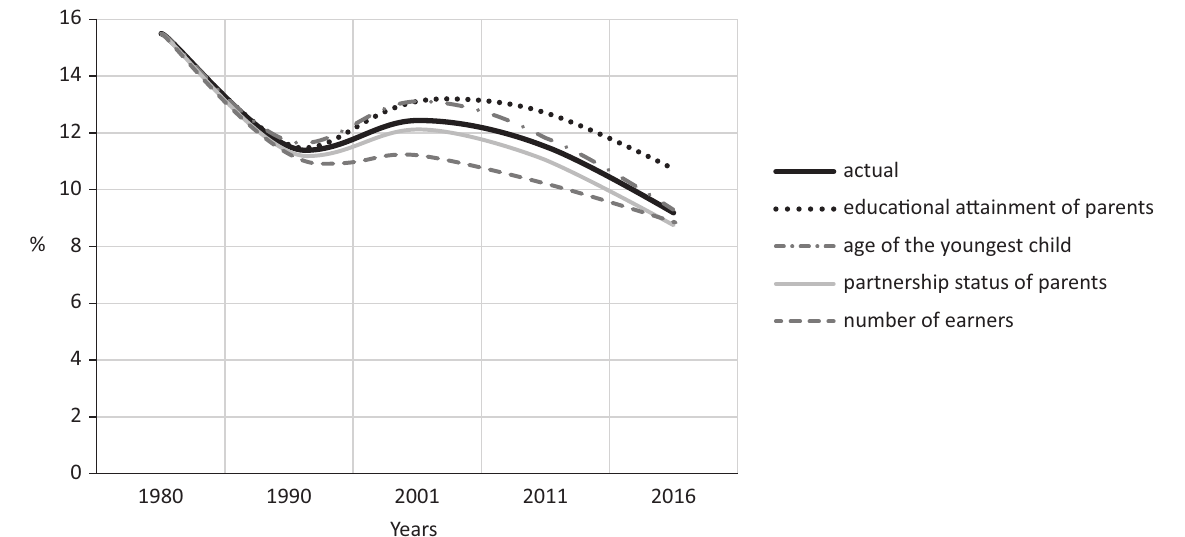
Figure 3. The actual and directly standardized ratio of TGHs. Note: The distribution of households in 1980 by each demo‐ graphic and sociological factor is used as a